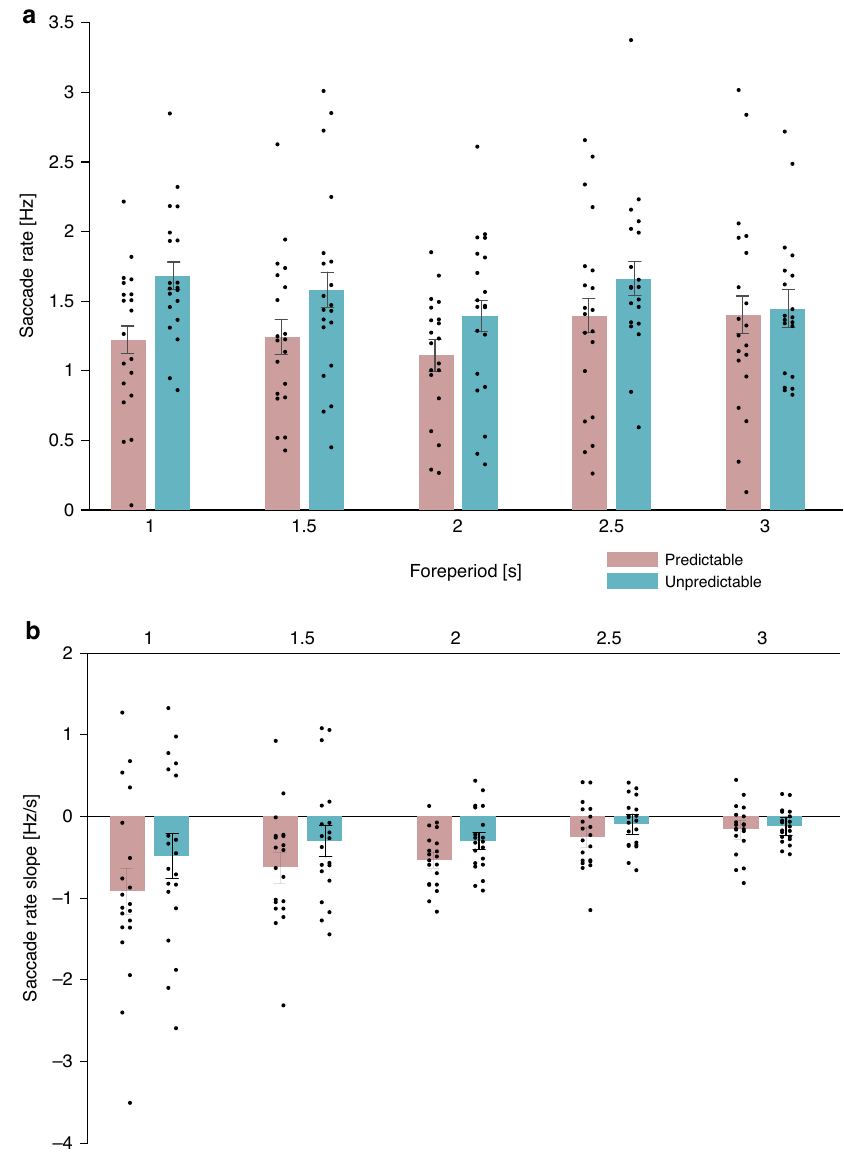
Fig. 4 Pretarget saccade rates by predictability and foreperiod. a Grand average pretarget saccade rate in the predictable (pink) and unpredictable (turquoise) conditions at − 100 to 0 ms relative to target onset. N = 20 participants.; b Saccade rate slope assessed by calculating the normalized difference between saccade rate in the interval 400 – 500 ms following cue onset and saccade rate in the interval − 100 to 0 ms relative to target onset at 0. This difference value was then divided by the time in seconds between the two intervals. Error bars denote ±1 standard error of the mean, corrected for within-subjects variability 60 . N = 20 participants. Source data are provided as a Source Data fi